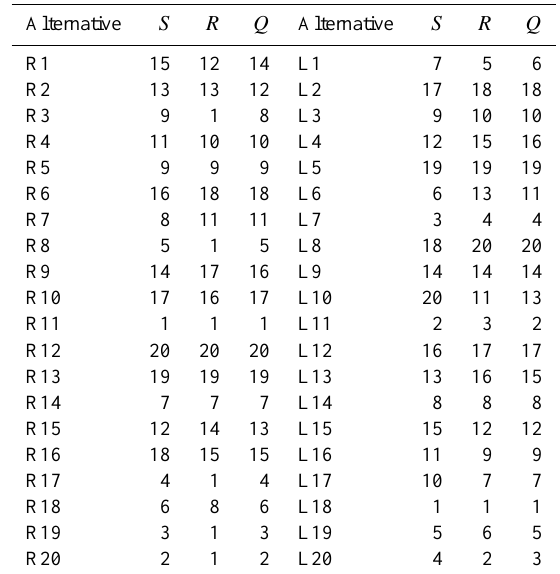
Table 3. Evaluation